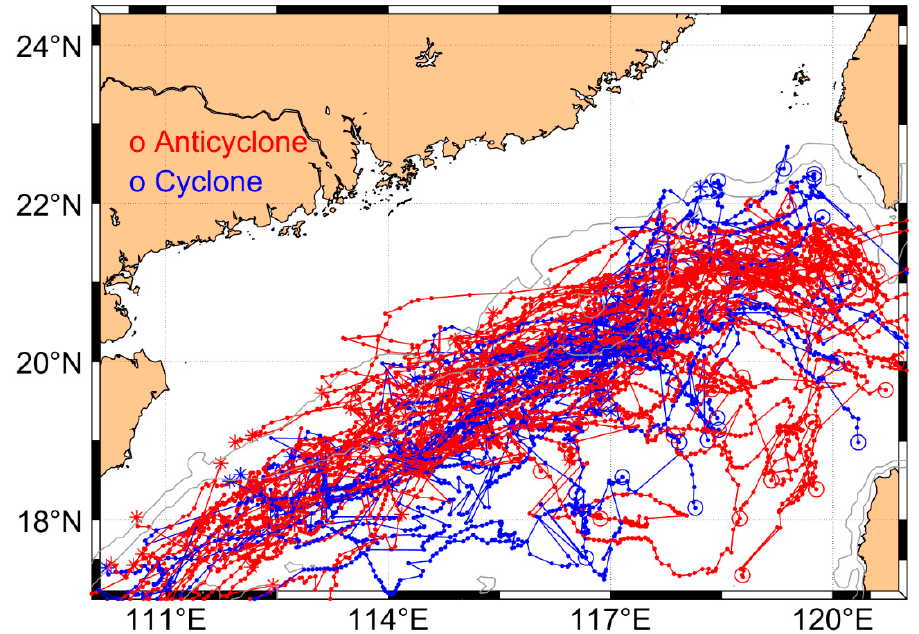
Figure 4. The pathways of the along-the-isobath type mesoscale eddies. The red curves with points are anticyclonic eddies. The blue curves with points are cyclonic eddies. The circles indicate generation and the asterisks indicate corruption.